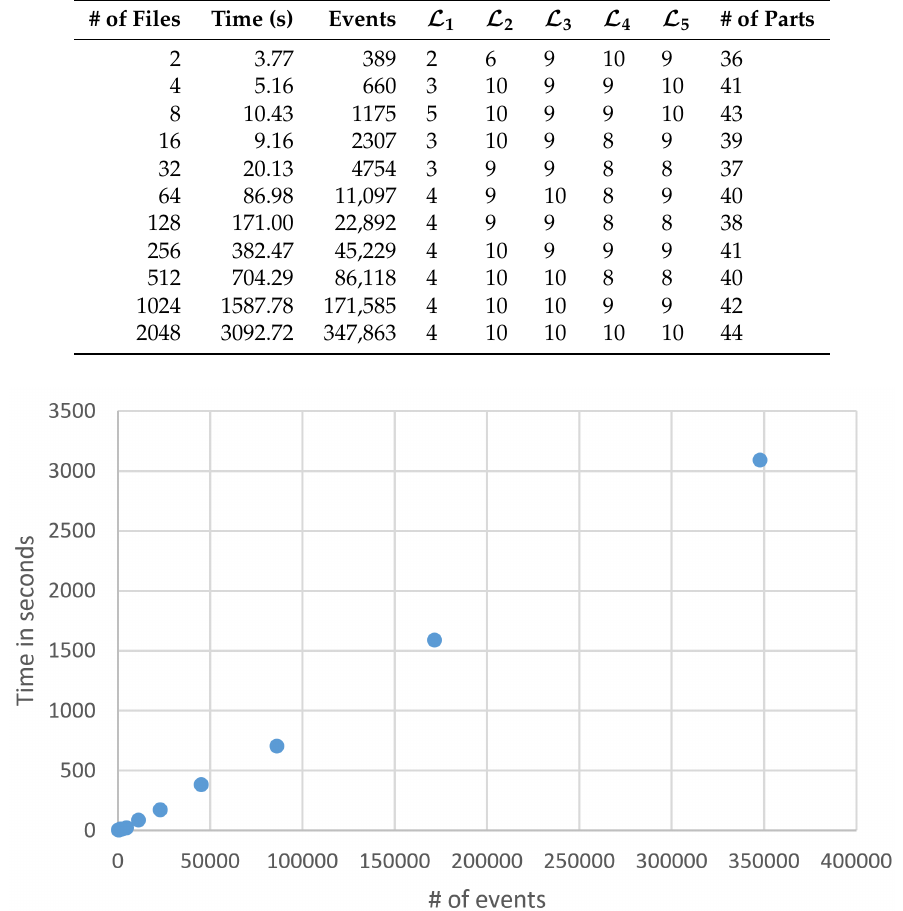
Table 1. The table summarizes the time needed and the number of learned parts when learning a five-layer model with a different number of input events. The left side of the table shows the number of music files and events in the input, along with the time needed to train a five-layer hierarchy. On the right side, the number of parts per individual layer, along with the sum of all parts in the hierarchy, is displayed.